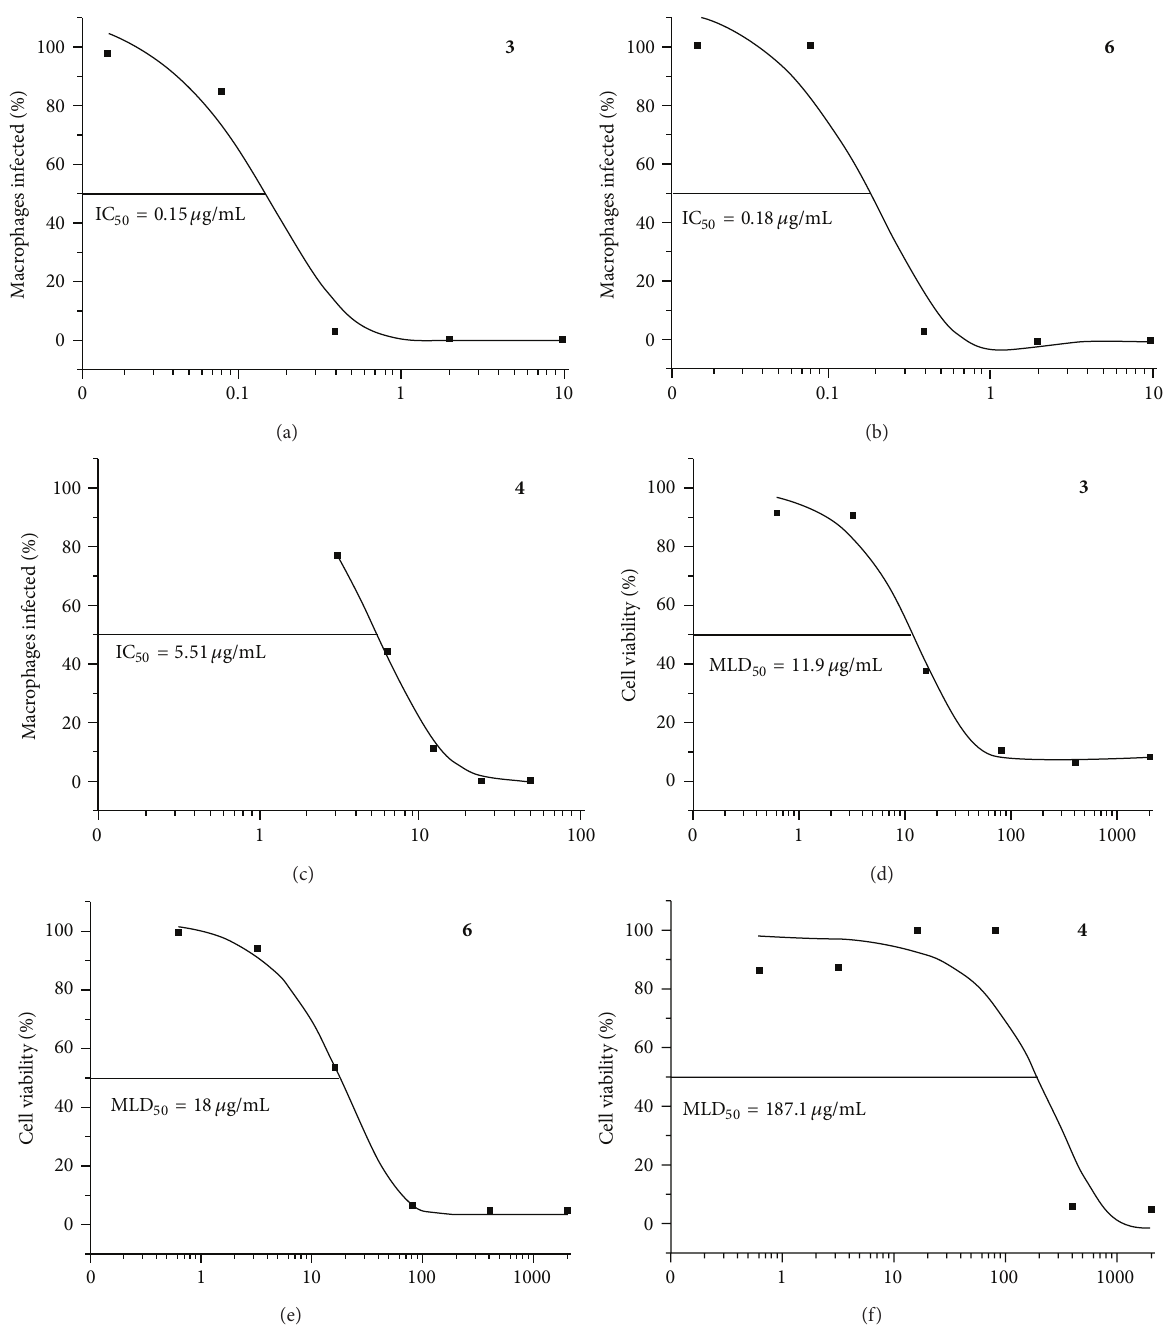
Figure2: Invitro antileishmanialactivityofcompounds( 3 ),( 4 ),and( 6 )againstintracellular L.amazonensis ((a),(b),and(c))andcytotoxicity against hepatoma HepG2 cell ((d), (e), and (f)). Curves were obtained using Microcal Origin Software. IC 50 = half-maximal inhibitory response; MLD 50 = the minimum lethal dose. Figures are a representation of one